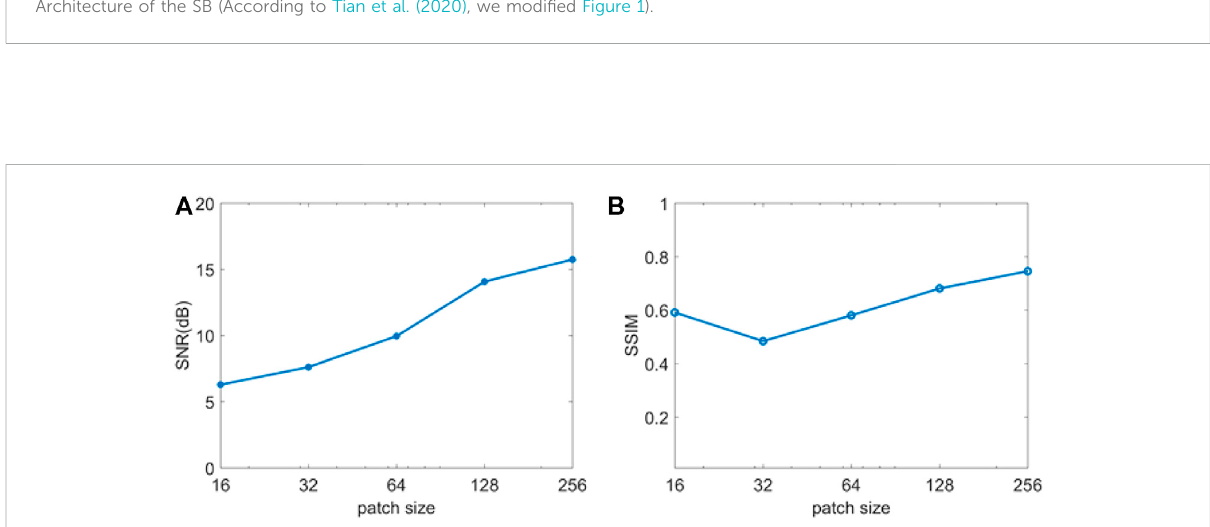
FIGURE 3 Comparison of denoised results when training the network with different patch sizes. (A) SNR comparison of denoised results, (B) SSIM comparison of denoised results.